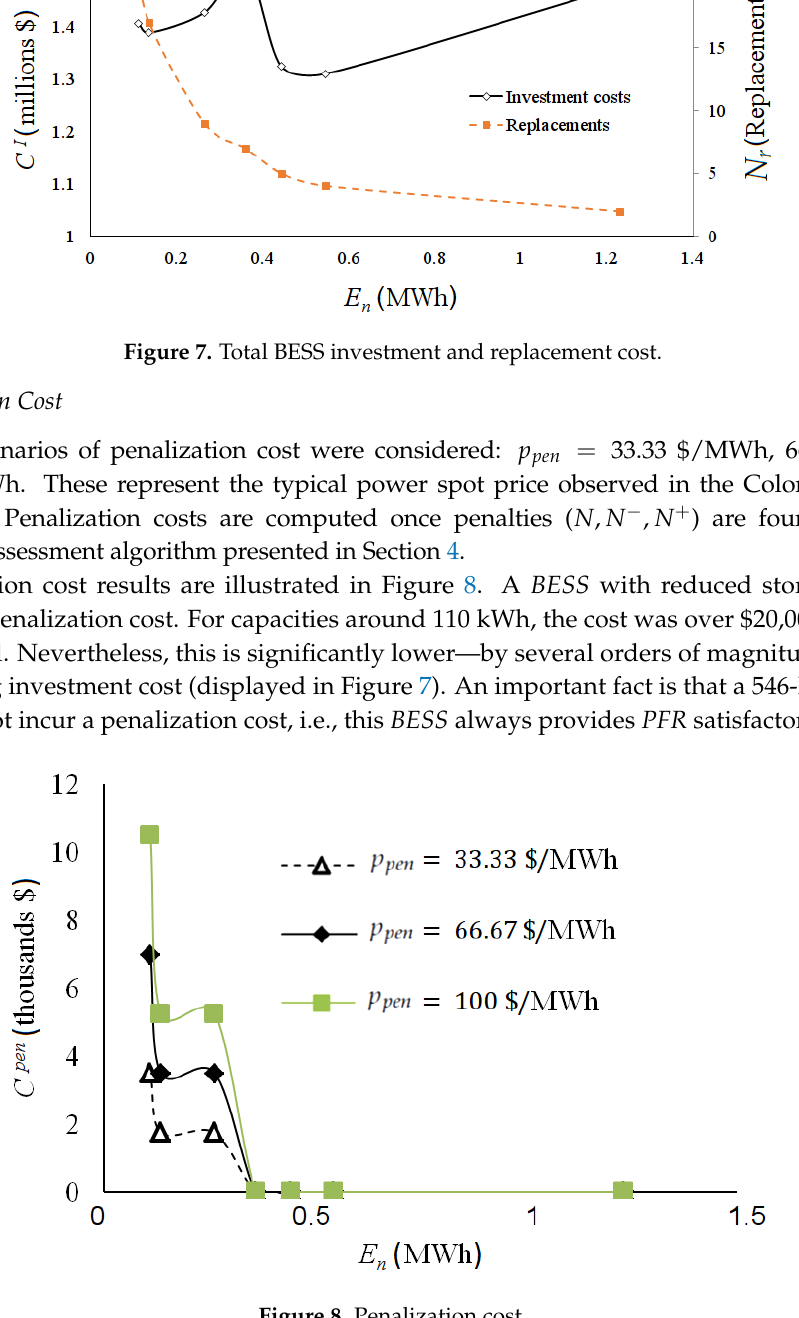
Figure 9. Dotted horizontal lines represent the SoC limits ( SoC max , SoC min ), while continuous horizontal lines are the target SoC band limits ( SoC +